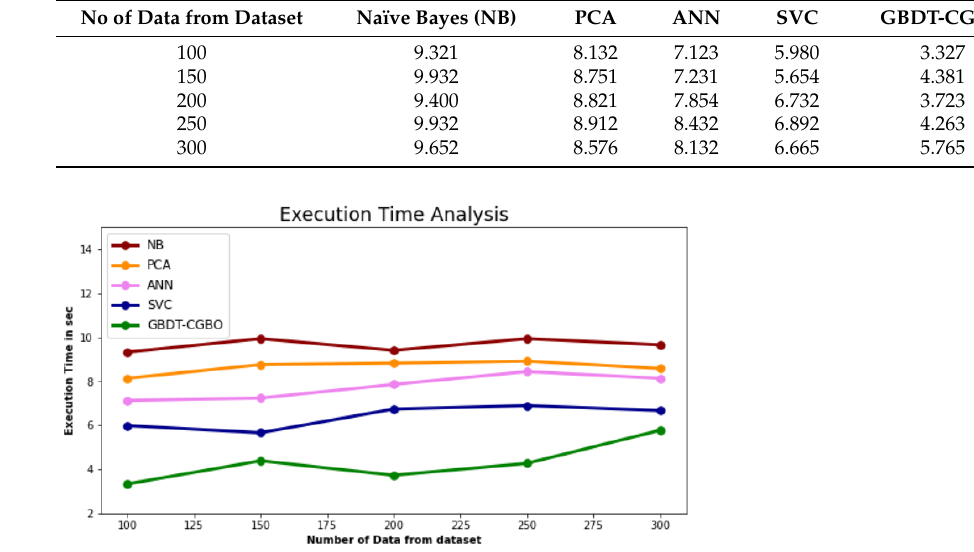
Table 5. Execution Time Analysis of GBDT-CGBO method with existing system in seconds.